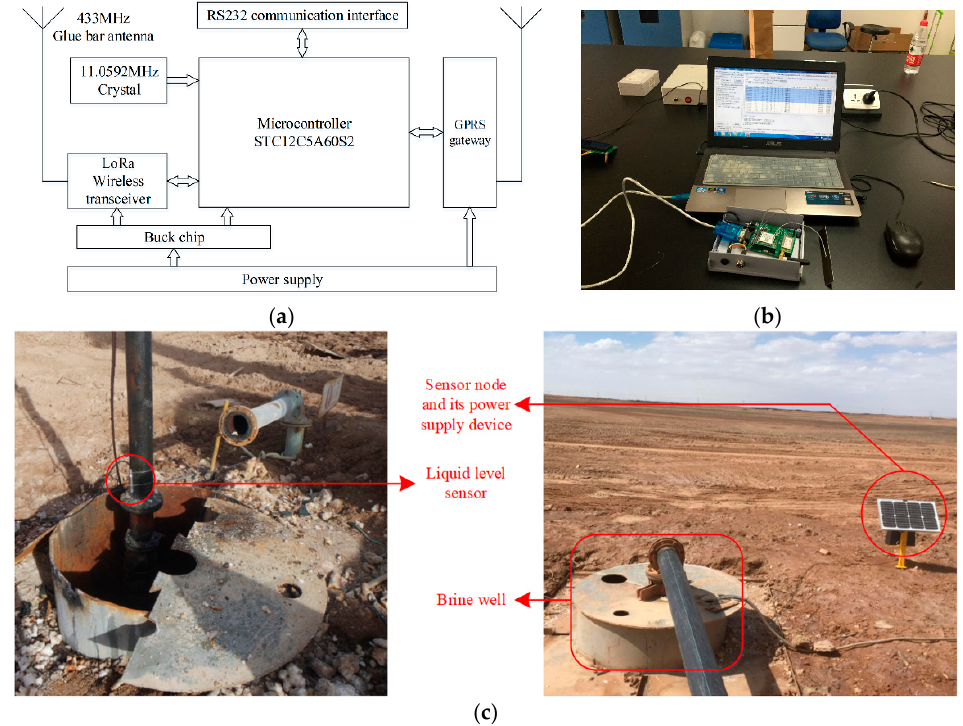
Figure 8. The implementation of gateway and installation of sensor nodes: ( a ) principle diagram of gateway; ( b ) gateway physical map; ( c ) physical diagram of sensor node installation.